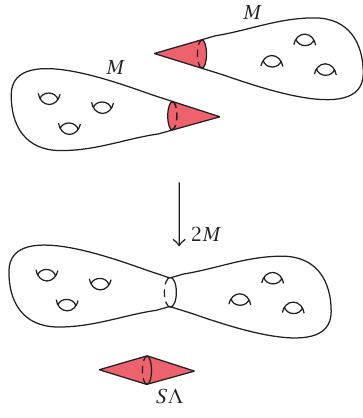
Figure 3.2. A surgery proving the index theorem for manifolds with conical